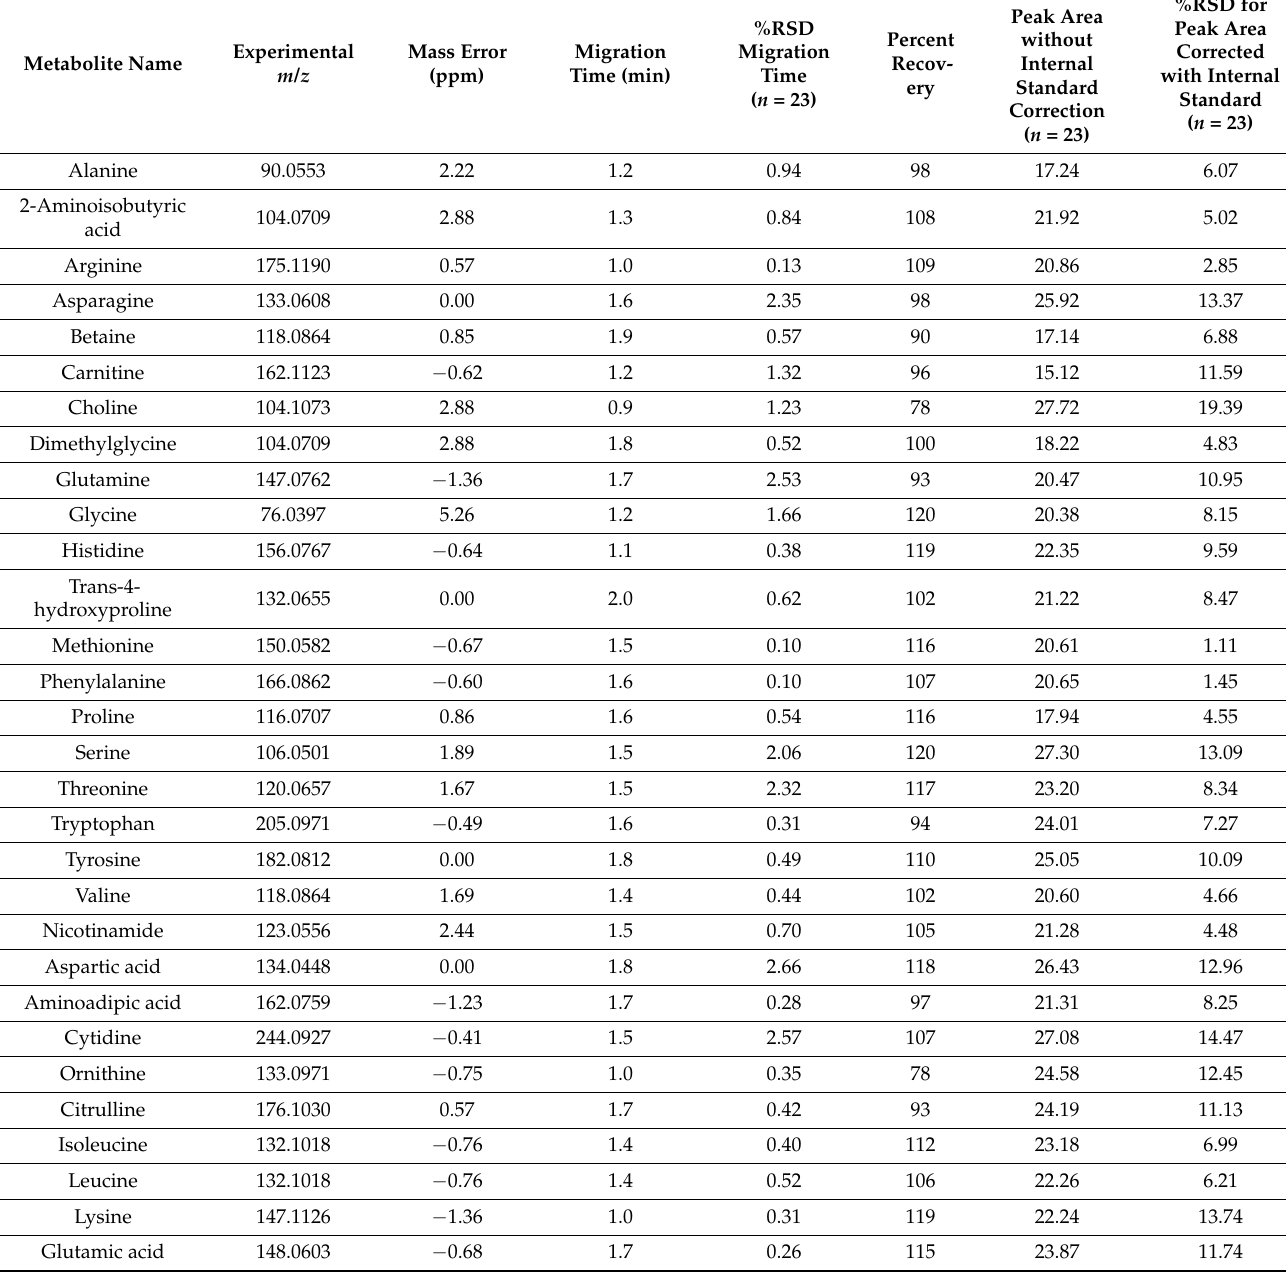
Table 2. µ CE-HRMS targeted metabolomics assay method validation in TKO mouse serum samples. Percent recovery was calculated using peak areas as follows: (peak area from spiked TKO serum–peak area of TKO serum)/peak area from neat standard mixture × 100%. RSD of peak areas with and without the normalization against the peak areas of the internal standards are